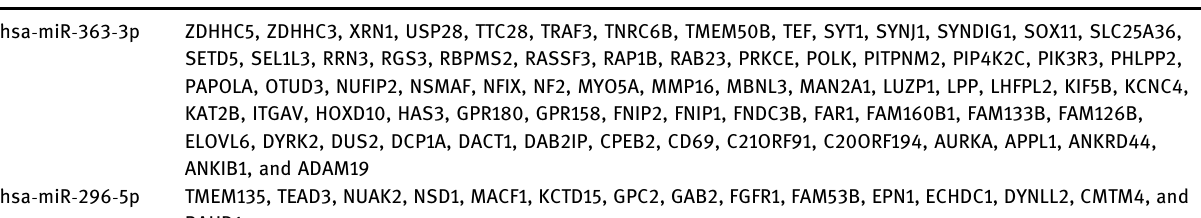
Table 4: miRNA - target interactions of hsa - miR - 363 - 3p, hsa - miR - 296 - 5p, hsa - miR - 221 - 3p, and hsa - miR - 155 - 5p according to miRDIP, miRWalk, miRDB, and TargetScan miRNA Gene